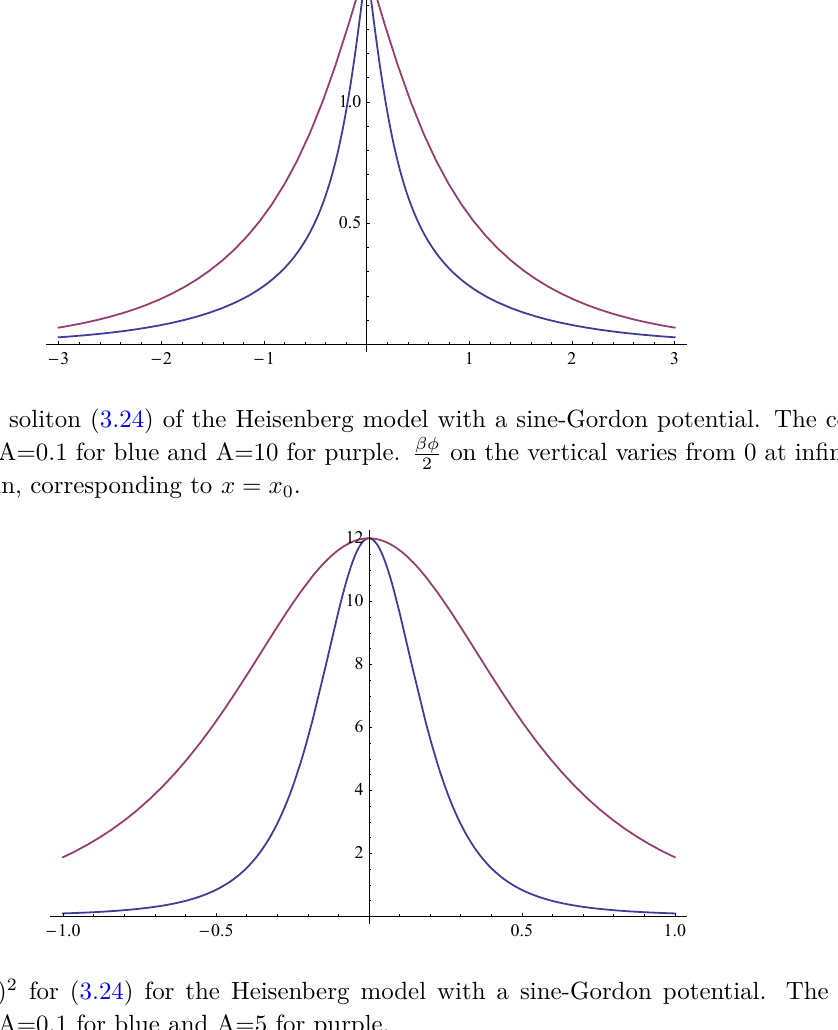
Figure 4 . ( φ 0 ) 2 for (3.24) for the Heisenberg model with a sine-Gordon potential. The colors correspond to: A=0.1 for blue and A=5 for